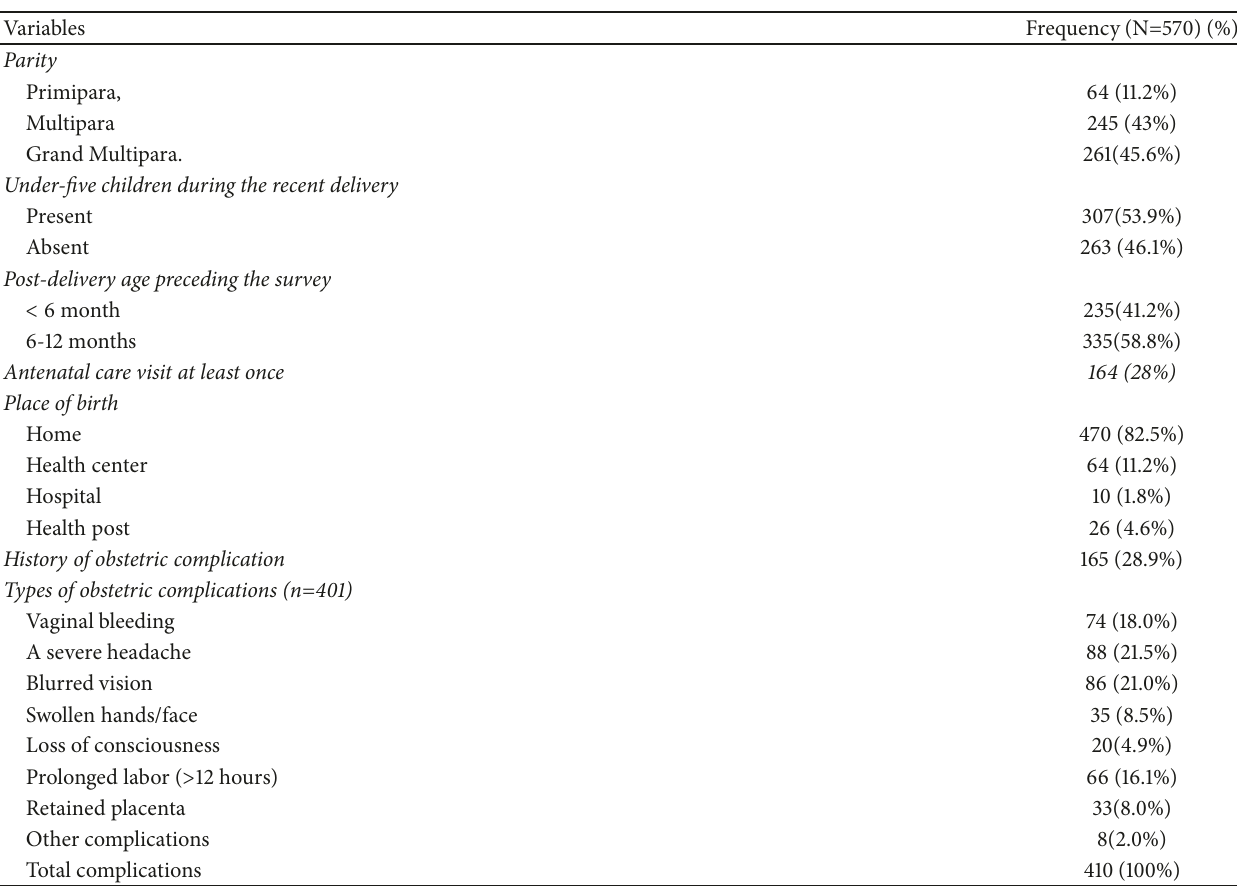
Table 2: Experiences of respondents who gave birth recently in Jardega Jarte district, Oromia Region, western Ethiopia, from January 1 to February 2, 2016.